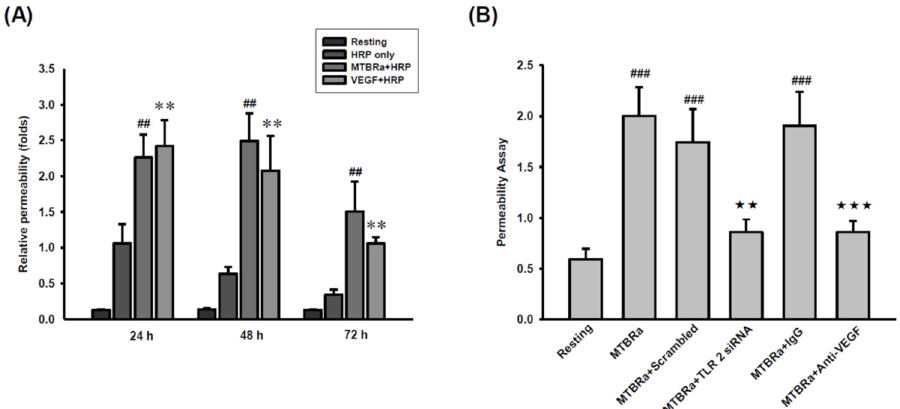
Figure 8. MTBRa induces pleural mesothelial hyperpermeability through TLR2/VEGF pathway. ( A ) MeT-5A cells were treated with HRP, MTBRa plus HRP, or VEGF plus HRP for the indicated times. ( B ) MeT-5A cells were transfected with scrambled or TLR2 siRNA, or pretreated with IgG isotype control or anti-VEGF neutralizing antibody, then stimulated with MTBRa for 48 h. The pleural mesothelial permeability was measured by a transwell permeability assay, as described in Materials and Methods . Data represented three independent experiments. ## p < 0.01, ### p < 0.001 compared with the resting group; ** p < 0.01 compared with cells treated with HRP only group. p < 0.01 compared with cells transfected with scrambled siRNA, followed by MTBRa treatment group; p < 0.001 compared with cells pretreated with IgG isotype and treated with MTBRa group. Data are representative of three independent experiments. HRP, streptavidin-horseradish peroxidase; MTBRa, Mycobacterium tuberculosis H37Ra.